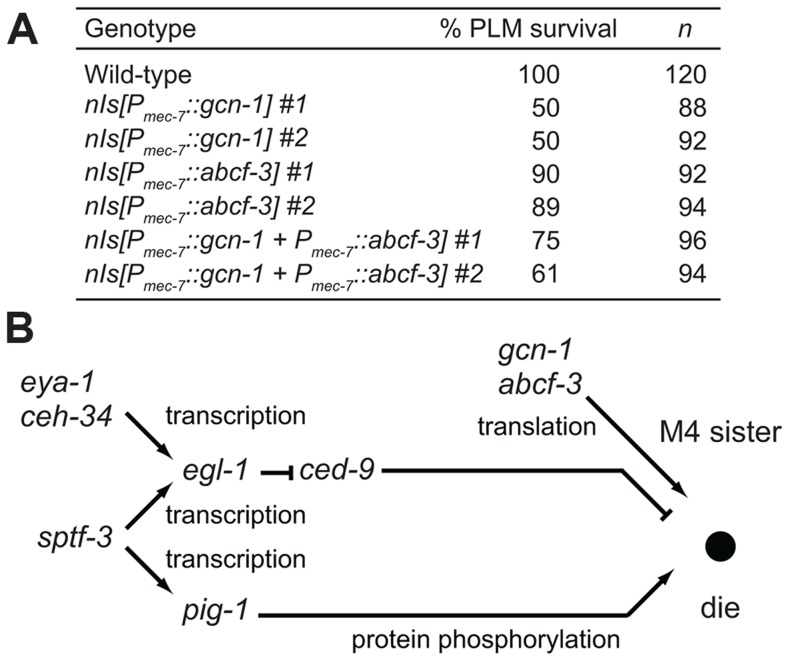
GCN-1 and ABCF-3 act cell-autonomously in a pathway distinct from the canonical cell-death execution pathway.(A) The percentages of PLM survival in animals of the indicated genotypes. All strains had the Pmec-4::gfp transgene that expressed GFP in the touch neurons, including the PLM neurons. (B) A model for the pathways that regulate M4 sister cell-specific programmed cell death. gcn-1 and abcf-3 act in a pathway distinct from the canonical ced-9-dependent cell-death execution pathway to promote M4 sister cell death. See text for details.